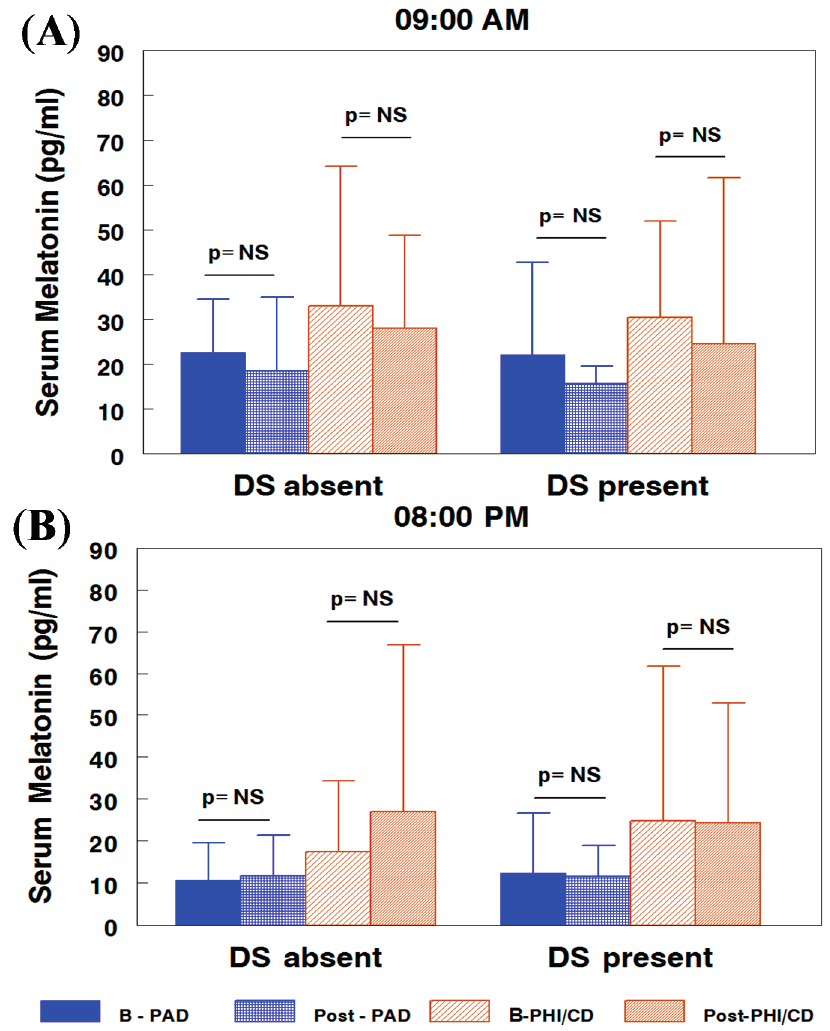
Figure 1. Melatonin concentration in Attention-deficit/hyperactivity disorder (ADHD) children grouped by ADHD subtype and depressive symptoms, in the morning ( A ) and at night ( B ). PAD, predominantly attention disorder; PHI/CD, predominantly hyperactive-impulsive/conduct disordered